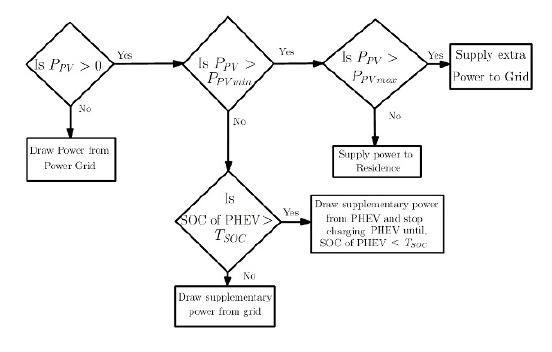
Figure 3. Flow Chart